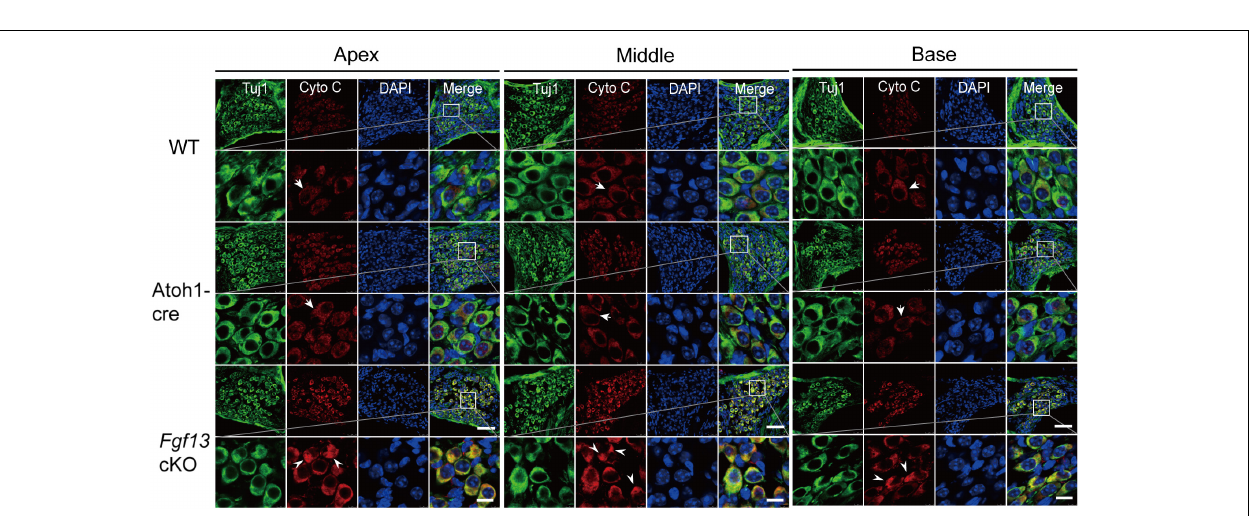
Frontiers in Cellular Neuroscience |